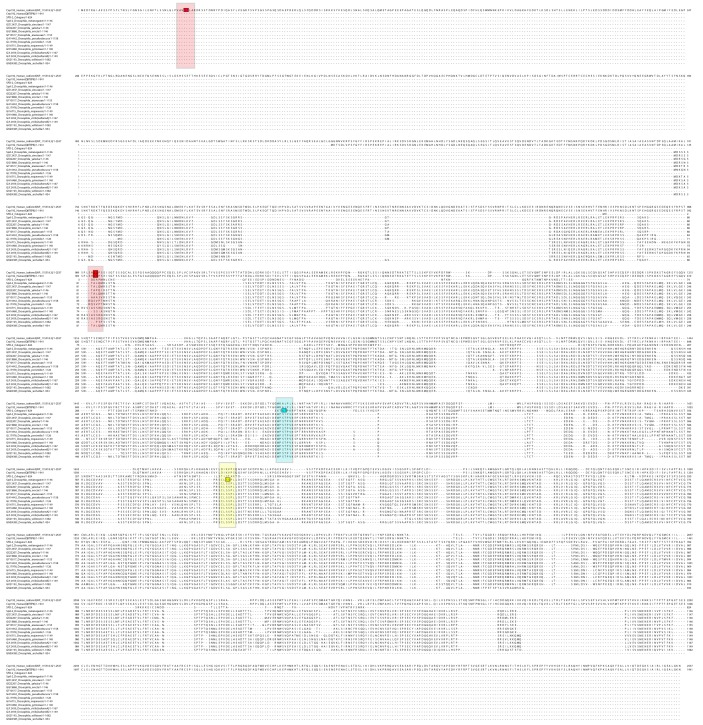
A multiple sequence alignment (MSA) of Spd-2 protein sequences from different species highlighting the known PBD binding motifs.The MSA aligns 13 different Spd-2 homologues from various Drosophila species with C. elegans SPD-2 and two isoforms of human Cep192. The previously identified Polo-binding sites in human Cep192 and C. elegans SPD-2 are indicated in boxes (red and blue, respectively), and the potential corresponding Drosophila sequences, if any, are highlighted in the larger surrounding boxes. No obvious Drosophila motifs are found at equivalent positions for the human Cep192 sites (red boxes) (although these regions of the protein do not align well so equivalent positions are difficult to infer), while there is a similar potential motif at an equivalent position to the single C. elegans motif (blue box). This motif is potentially phosphorylated by Cdk1, so we also mutated a second nearby S-S/T sequence that is conserved in Drosophila that could be phosphorylated by Cdk1 (yellow box) to generate the Spd-2-AA-mKate2 construct.